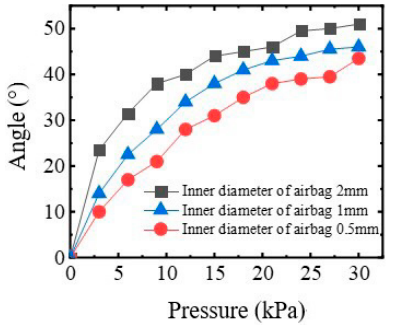
Figure 7. The bending angle under various pressure.